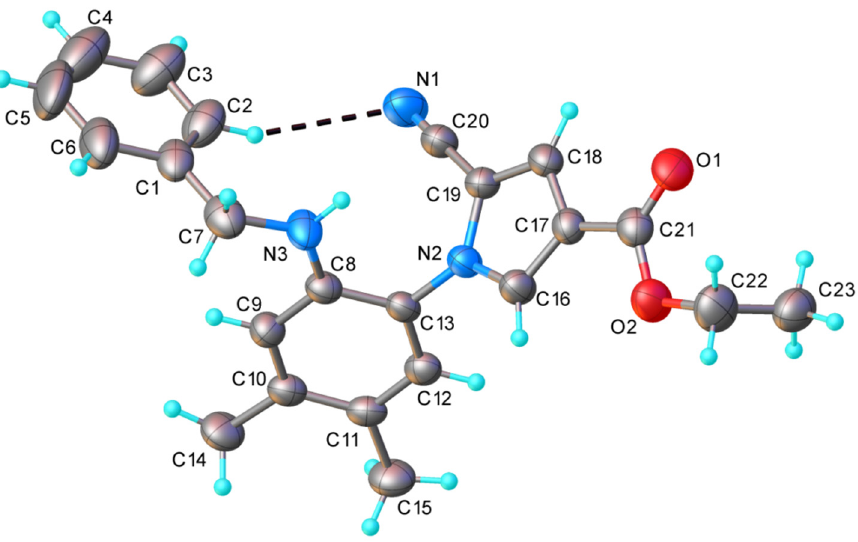
Figure 2. X-ray molecular structure of compound 4d with atom labeling and thermal ellipsoids at the 40% level. Intramolecular H-bond parameters: C2-H···N1 [C2-H 0.93 Å, H···N1 2.73 Å, C2···N1 3.608 Å, ∠ C2HN1 158.3°].